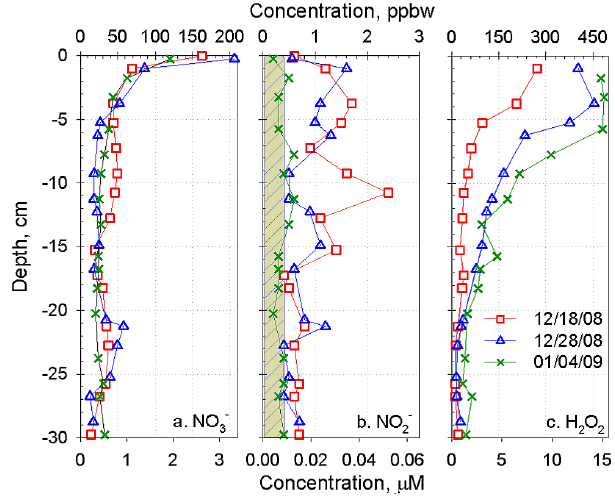
Fig. 6. Snow concentrations of (a) NO − measured in the 30cm-depth snow pits dug on 18 December 2008 (red squares), 28 December 2008 (blue triangles) and 04 Jan- uary 2009 (green crosses). The shaded area in (b) represents the NO − 2